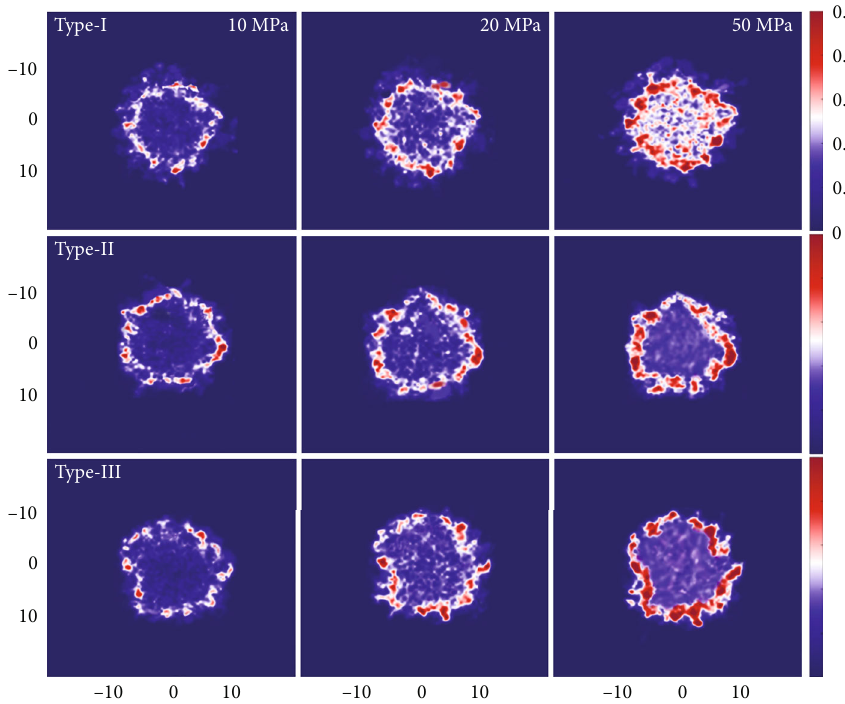
Figure 4: CH density distribution in 2nm shale organic nanopore under di ff erent pressure 4